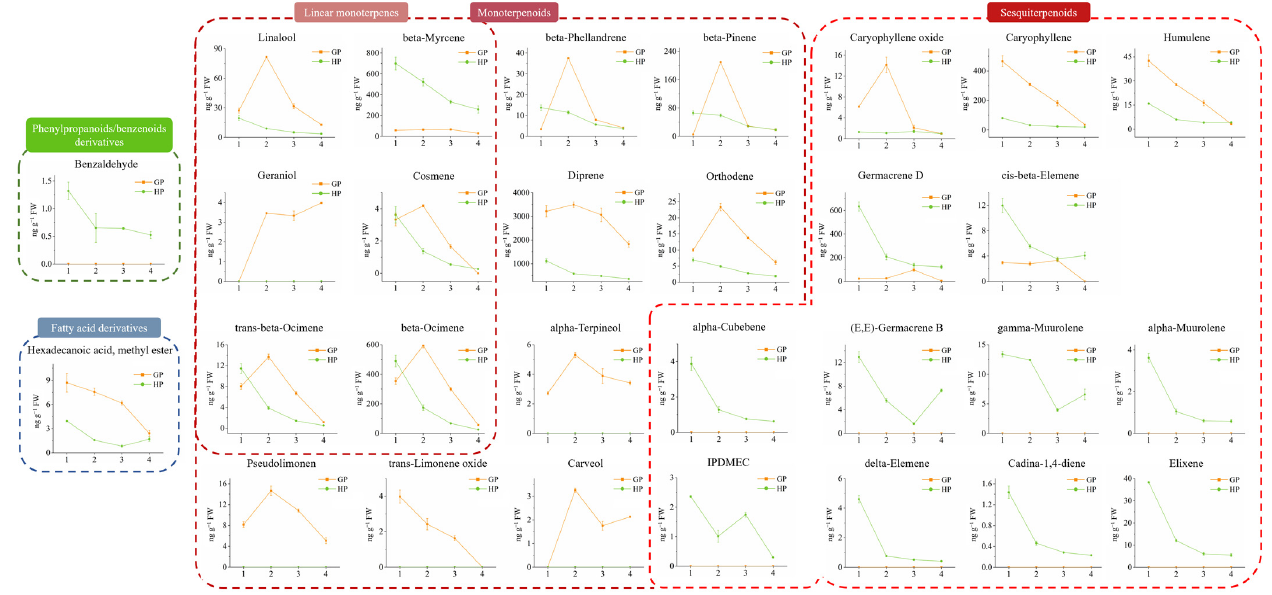
Figure 4. Varied contents of volatiles during young pomelo fruits development. IPDMEC: (1R,7S,E)- 7-Isopropyl-4,10-dimethylenecyclodec-5-enol.